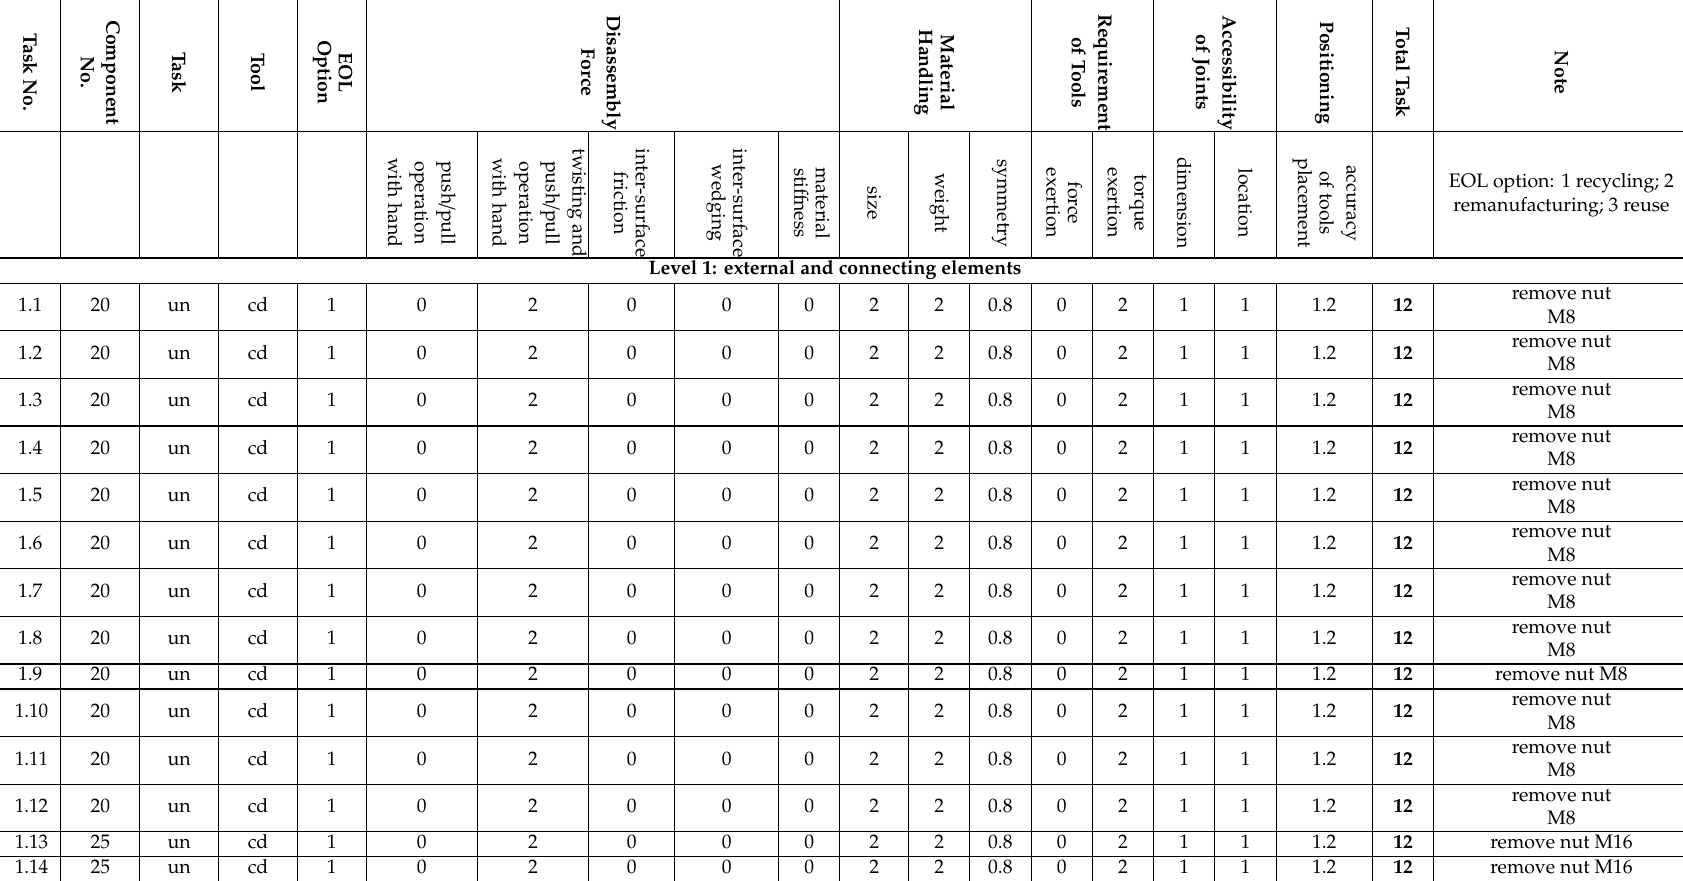
Table A2. Time calculation with Mitrouchev